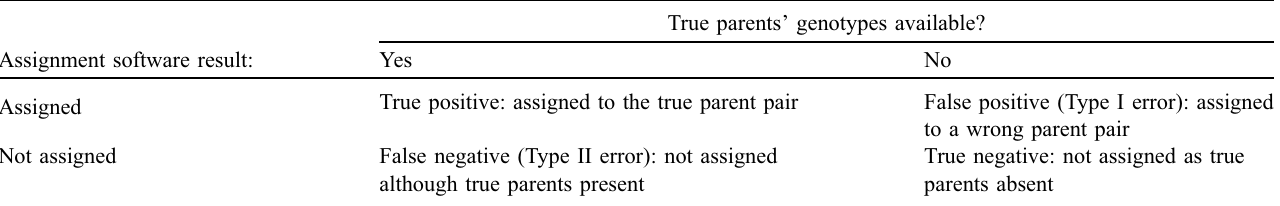
True parents ’ genotypes available?